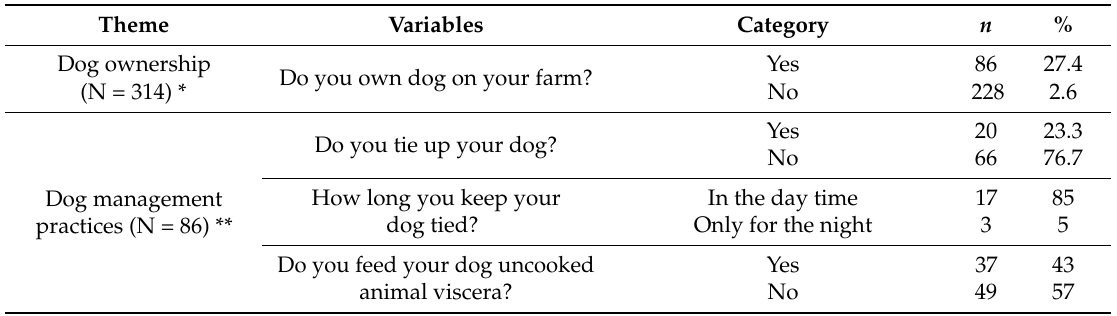
Table 2. Descriptive results of livestock farmers’ practices relevant to CE prevention and control.